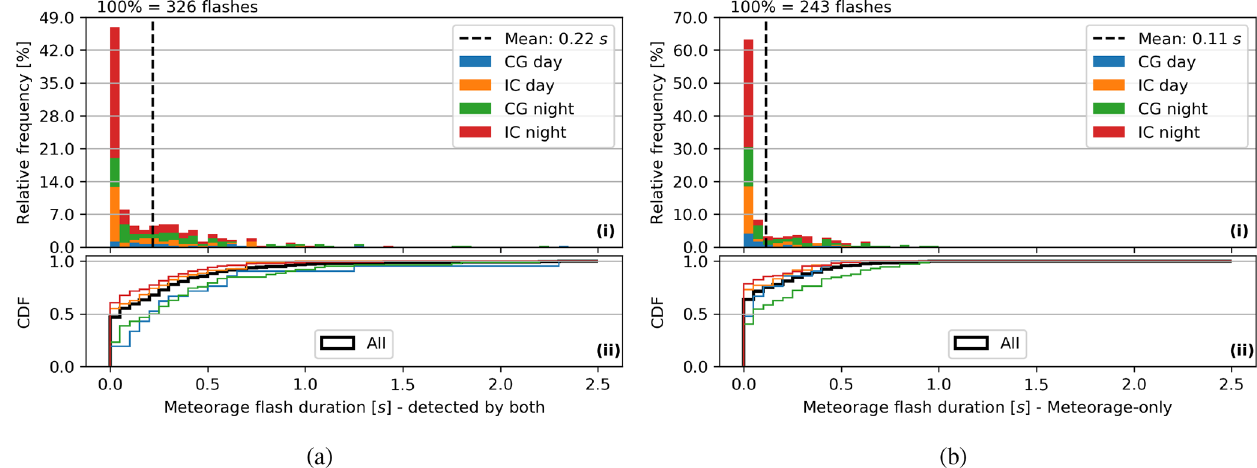
Figure 12. Meteorage flash duration with a coincident ISS-LIS flash (a) and unmatched Meteorage flashes (b) . Daytime, nighttime and flash type, IC and CG, are indicated by the colors. The histogram (i) and corresponding CDF (ii) use the same colors. The CDF additionally shows a black curve for all data. The histogram bin width is constant at 0.05s. The mean value is plotted as a dashed line. The total number of flashes is indicated above the